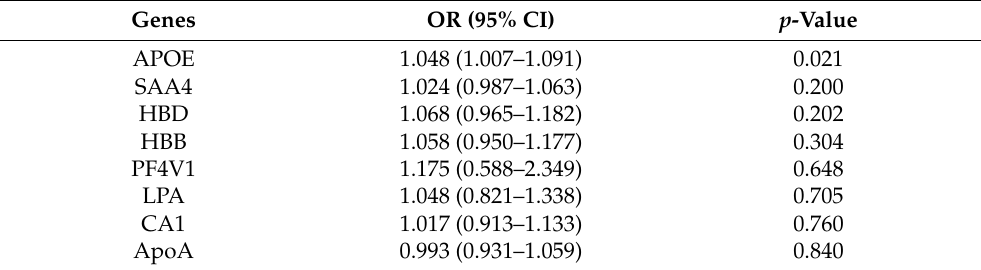
Table 8. Saturated multivariate logistic regression model including all selected exosomes (ApoA, HBB, CA1, Lp(a), SAA4, PF4V1, ApoE, and HBD), with the outcome Advanced Stage EC patients vs. controls.